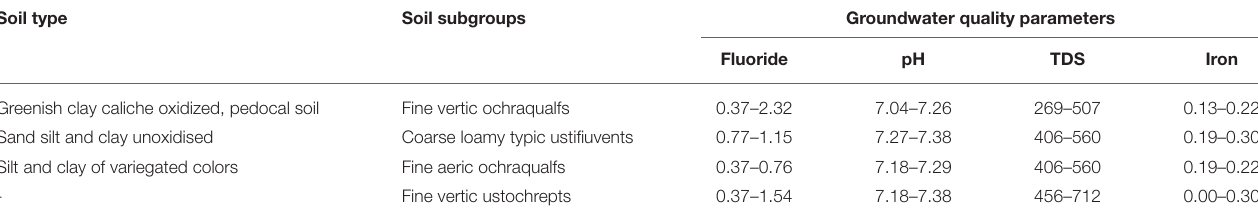
TABLE 3 | Summarized relationship between soil types and groundwater